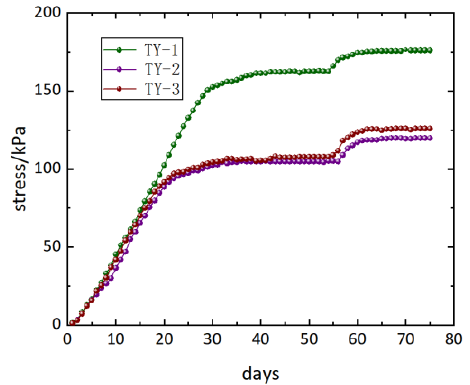
Figure 7. Field monitoring data curve of earth pressure box.